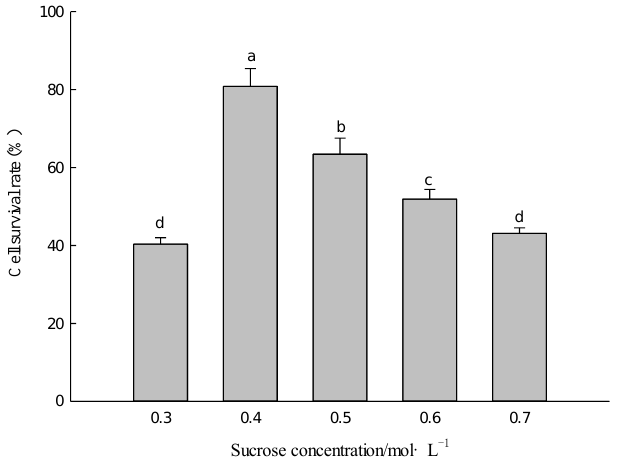
Figure 2. Effect of sorbitol concentration on the survival percentage of embryogenic callus of F. mandshurica after cryopreservation by slow cooling. Note: Lowercase letters represent significant differences at p < 0.05.